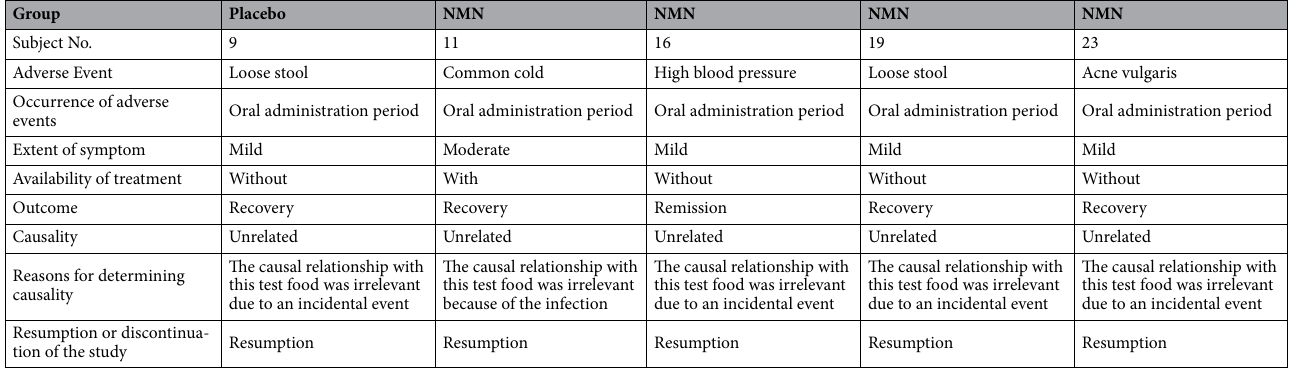
Table 6. Adverse events during the clinical